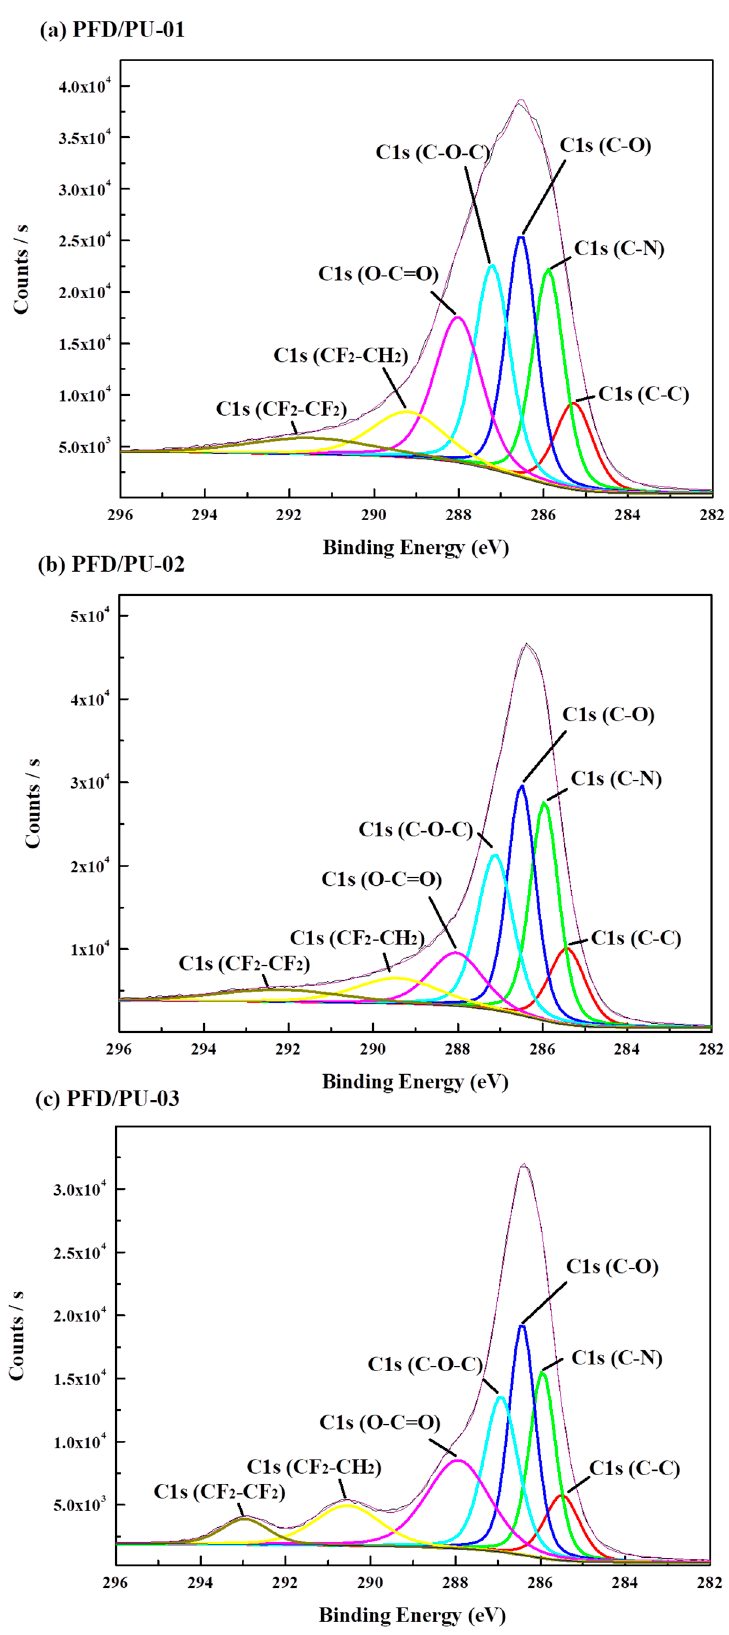
Figure 11. C1s fit theory of PFD/PUs.